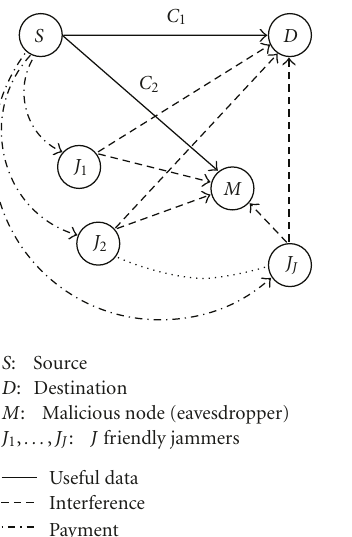
Figure 2: Secrecy capacity versus the power of the single